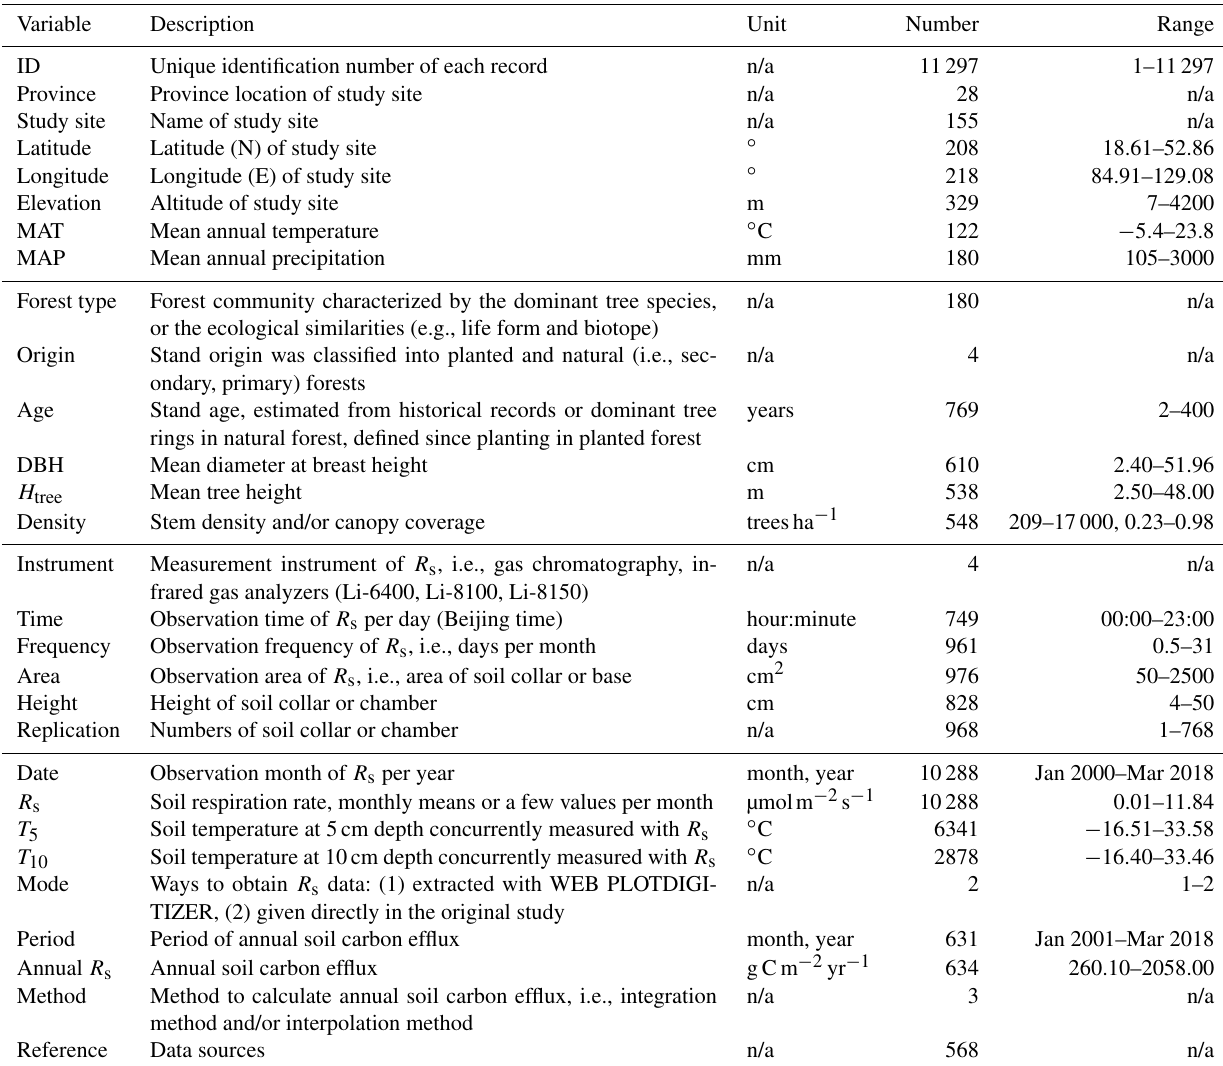
Table 1. Variable information of soil respiration dataset in China’s forest ecosystems, available at https://doi.org/10.1594/PANGAEA.943617 (Sun et al., 2022). n/a refers to values that are not